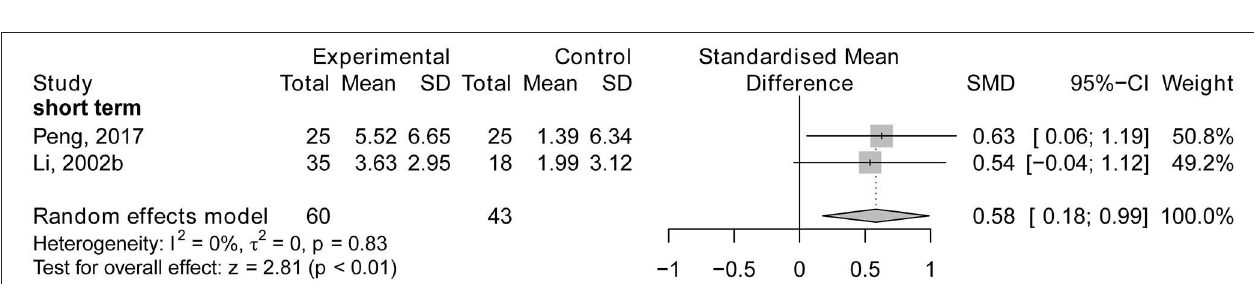
after long-term treatment (after treatment: the experimental group, 20.15 ± 1.08; the control group: 25.31 ± 1.69; p <